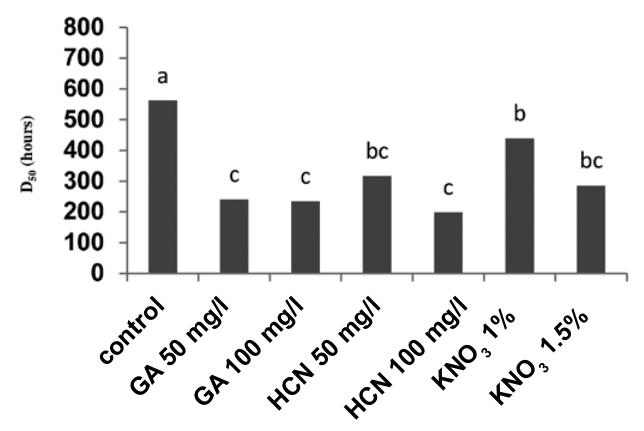
Fig. 4 - Effect of different priming agents on time to reach 50% germi- nation (G ) of Shapasand pistachio variety. 50%